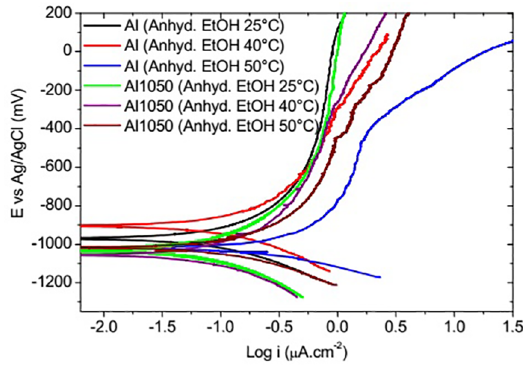
Figure 2. Potentiodynamic polarization curves for commercial grade aluminum (Al) and Al 1050 alloy in anhydrous ethanol at 25°C, 40°C and 50°C.